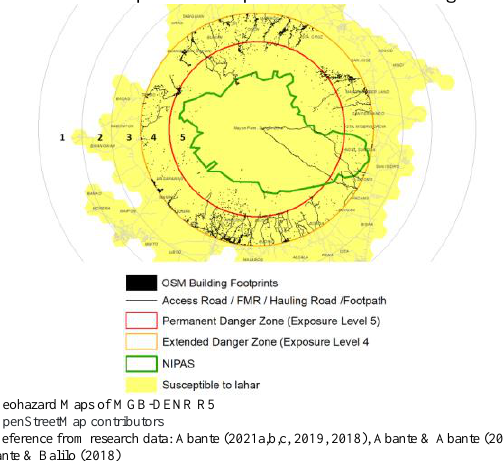
Figure 10 . OSM road and building footprints exposure levels